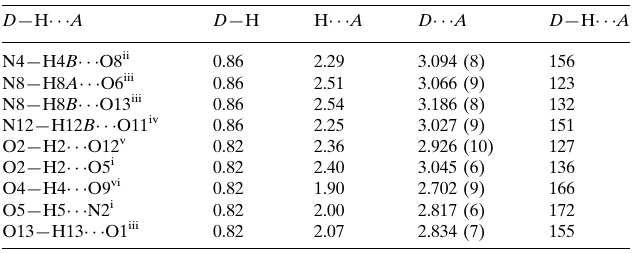
Hydrogen-bond geometry (A˚ , (cid:2)